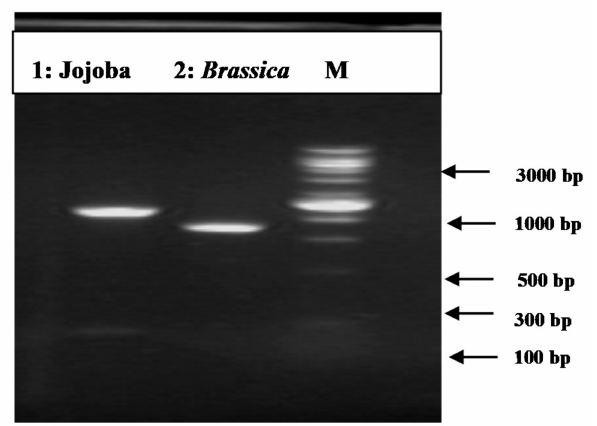
Figure 3. PCR amplification of targeted PCR fragments in Lane (1) from jojoba ( Jojo-Gly I ) with glyoxalase I ( Gly I ) of the gene confer tolerance in plants under stress compared with Lane (2) from Brassica juncea (Accession number: embY13239.1). The “100 bp ladder” was used as a size marker.